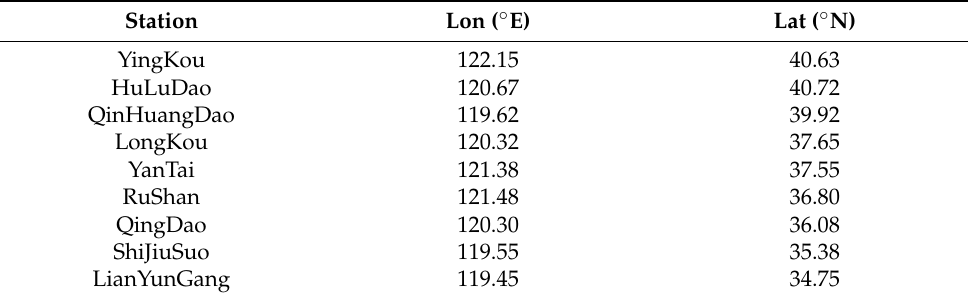
Table 1. Tidal stations used in the